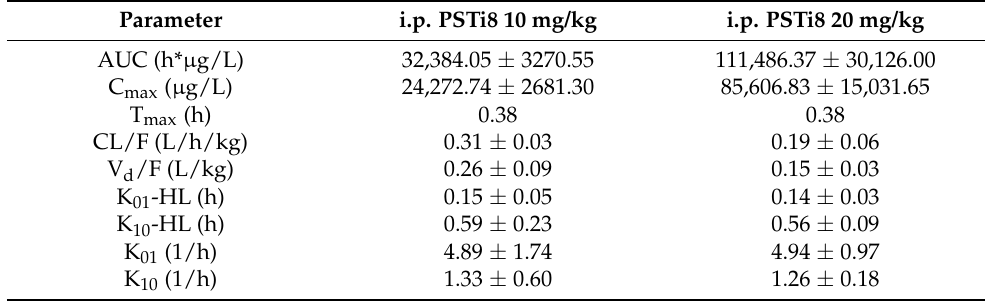
Table 3. Pharmacokinetic parameters of the PSTi8 peptide after i.p. administration at two doses of 10 and 20 mg/kg in male SD rats. Data are represented as the mean ± SD with n = 6.